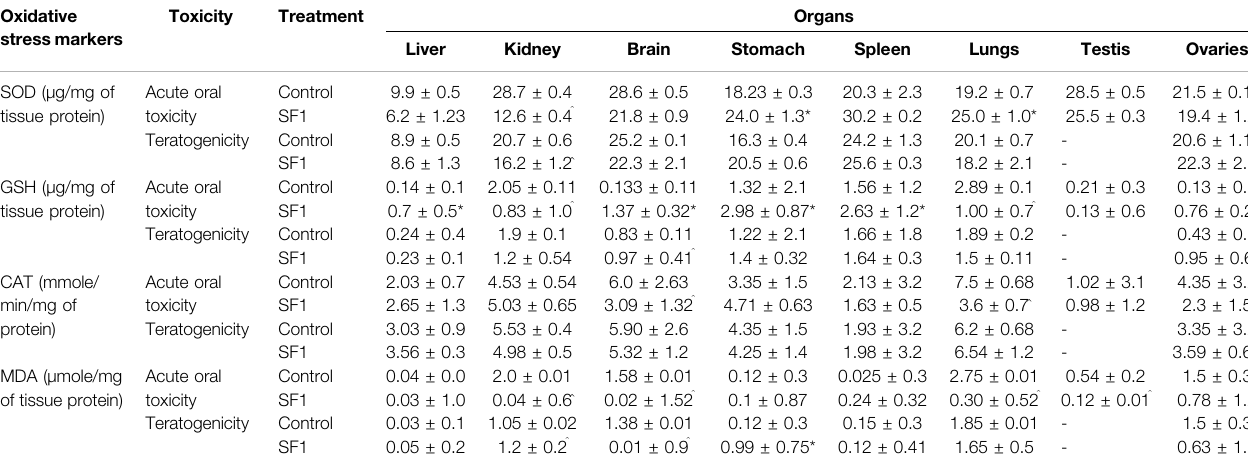
TABLE 8 | Effect of SF1 treatment on oxidative stress biomarkers of selected organs during acute oral toxicity and teratogenicity study. Oxidative Toxicity Treatment Organs stress markers Liver Kidney Brain Stomach Spleen Lungs Testis Ovaries SOD (µg/mg of tissue